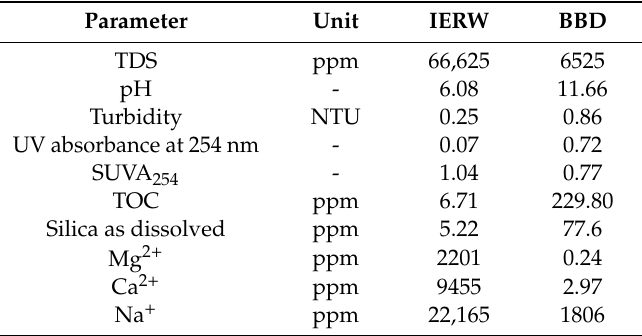
Table 1. Properties of the boiler-blow down (BBD) waste and ion exchanger regeneration wastewater (IERW)